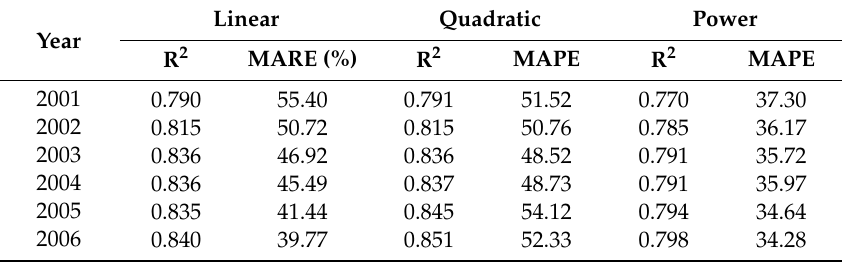
Table 5. Model fitting precision values between TNL and GDP in provincial